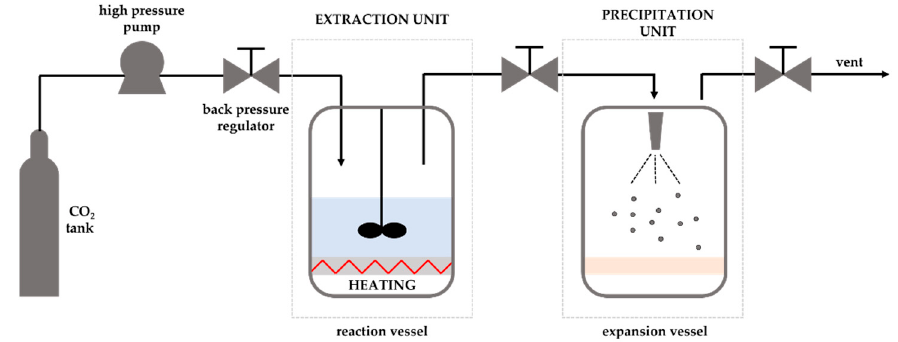
Figure 14. Flow chart of supercritical fluid technology.